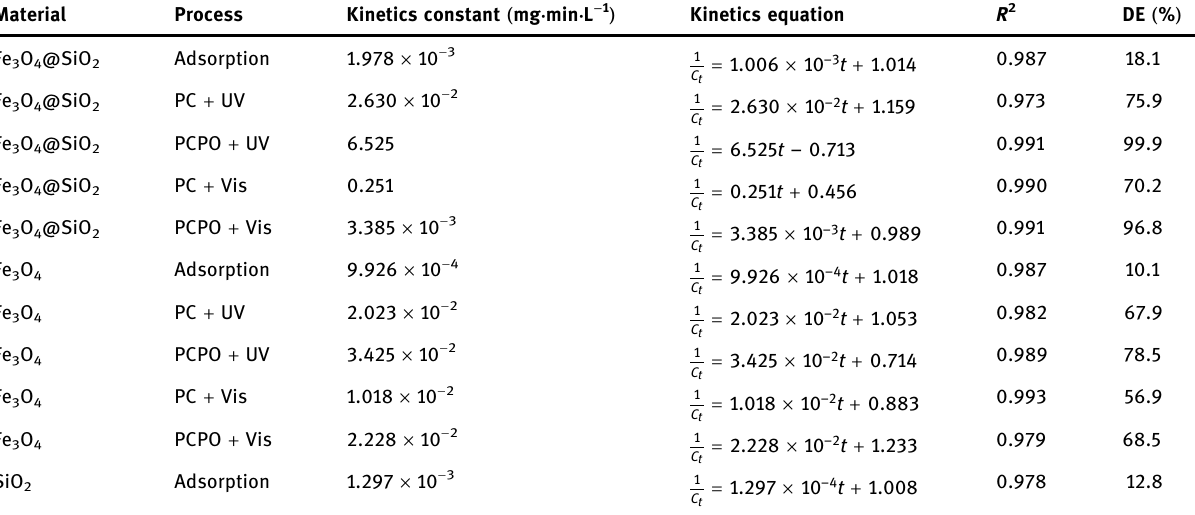
Table 5: Calculated parameters from kinetics studies